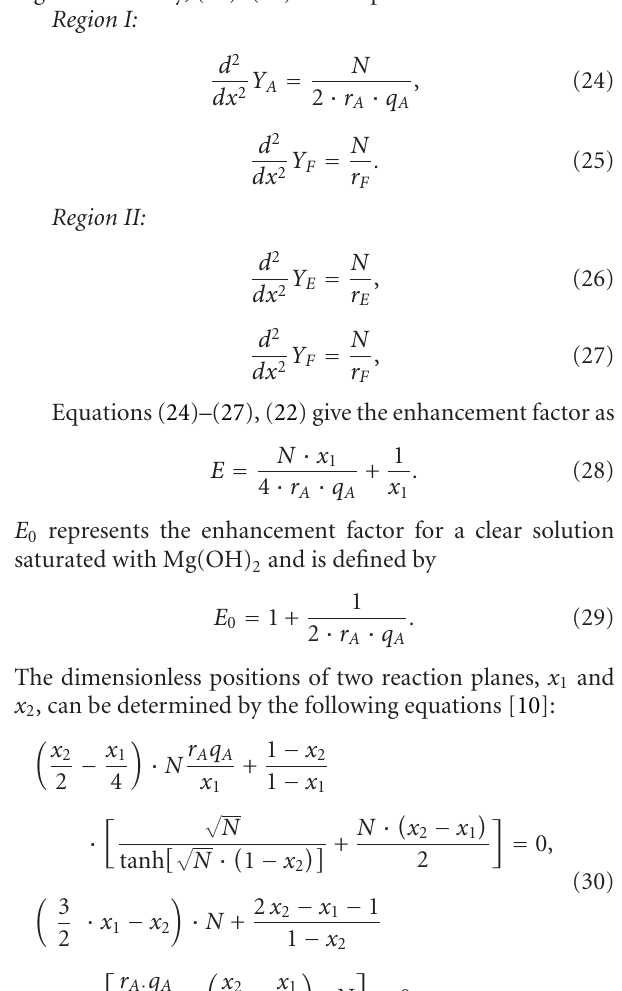
The mass balance equations in the dimensionless form reduce to the